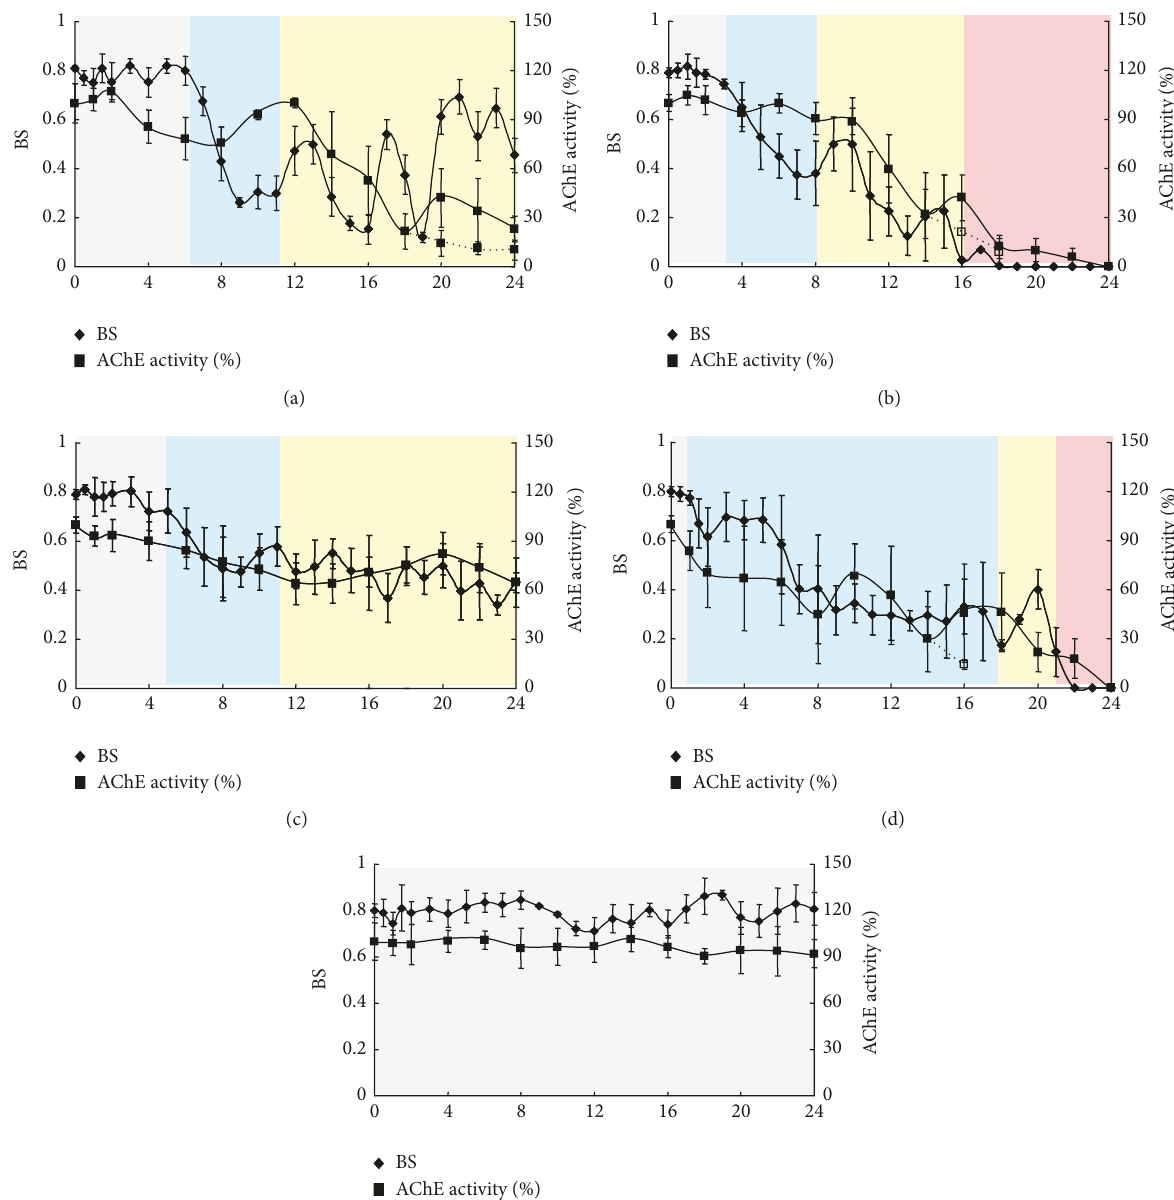
Figure 1: The swimming behavior and the AChE activity (% of control) inhibition of D. magna after in vivo exposure in both DM and MT. M ± SD was applied. (a, b, c, d, and e) Showing the behavior responses and AChE activity of D. magna in 13.36 𝜇 g/L DM, 33.40 𝜇 g/L DM, 19.66 𝜇 g/L MT, 49.15 𝜇 g/L MT, and control, separately. AChE activity of D. magna in control at the beginning of the experiments is regarded as 100%. The solid line with round dots represented the behavior responses of D. magna. The solid line with triangles represented the AChE activity of live D. magna and the dotted line with triangle represented the AChE activity of dead D. magna once there were some individuals that died during the exposure periods. Gray shadows mean no effects and stimulation, blue shadows mean the acclimation, yellow shadows mean the (re)adjustment, and red shadows mean the toxic